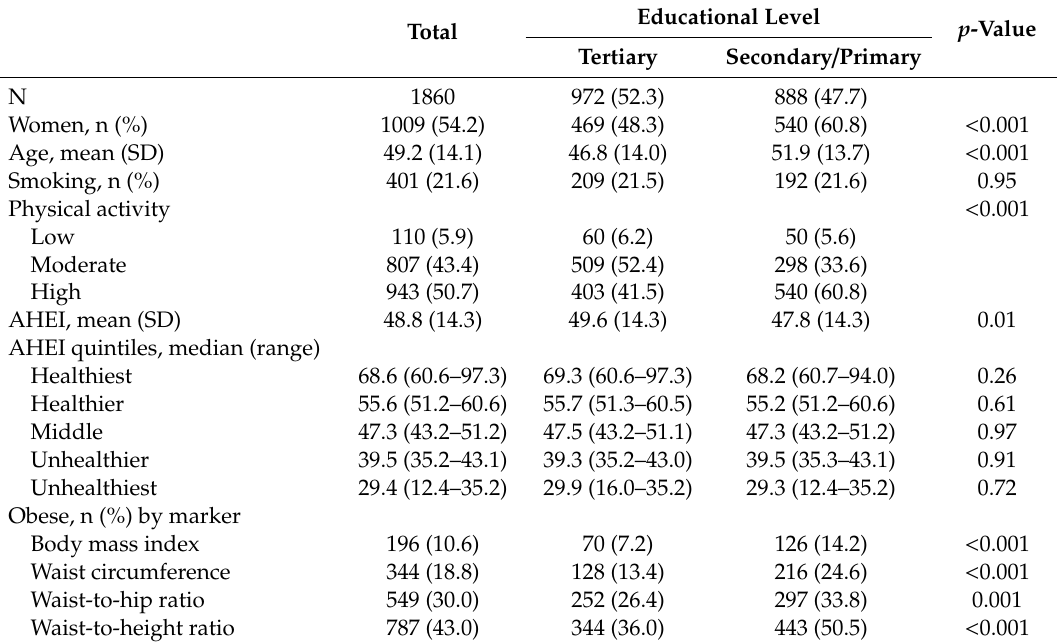
Table 1. Description of the included sample, menuCH survey, Switzerland,